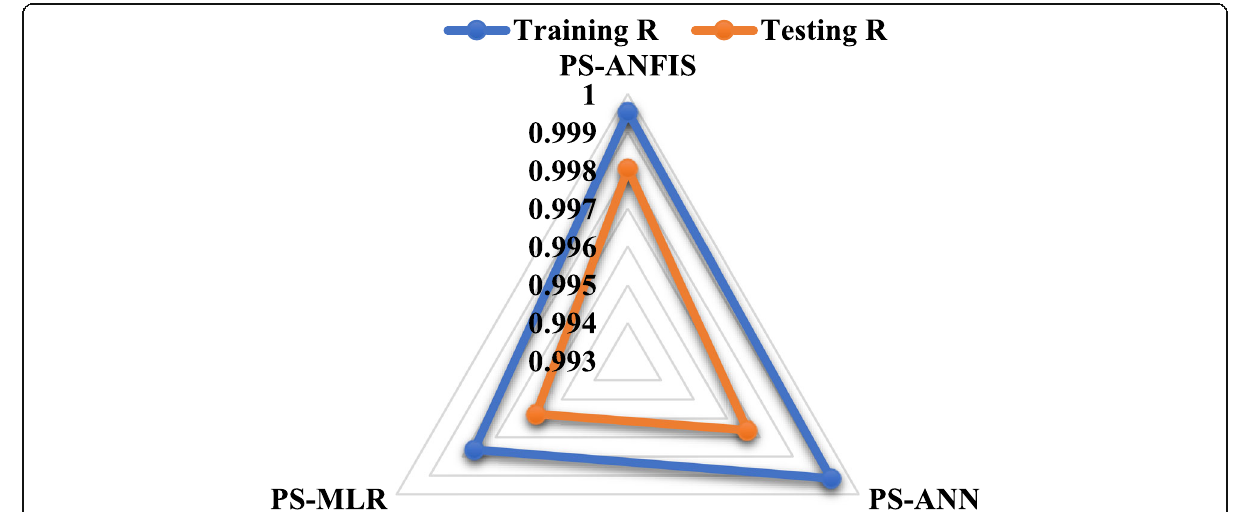
Fig. 6 Radar chart of modified starch PS in both training and